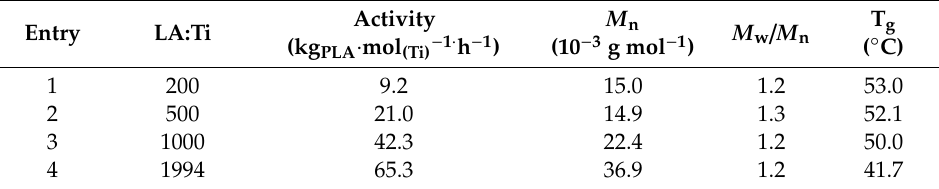
Table 19. Thermally induced polymerization of r- lactide catalyzed by 23 [31].